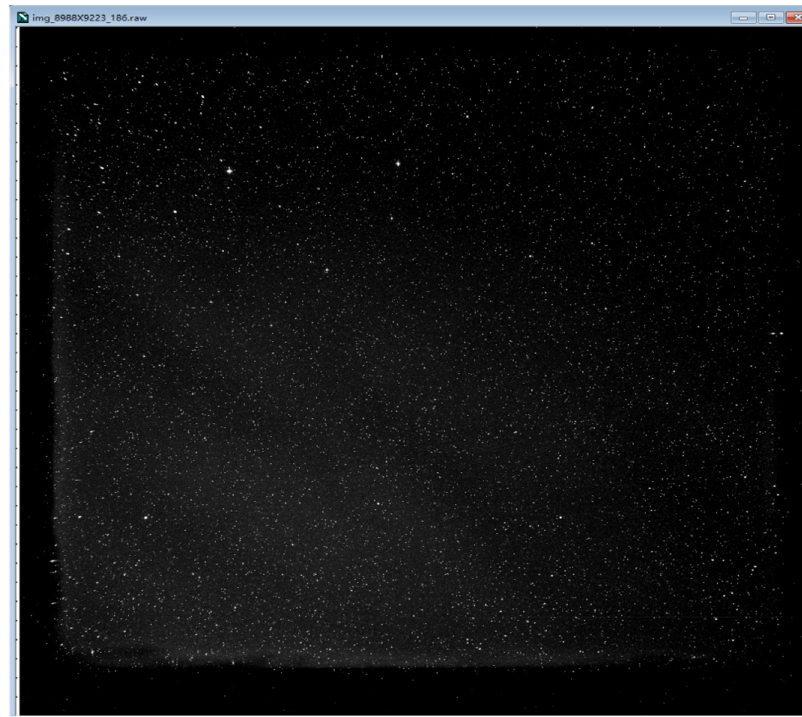
Figure 12. The star map image used this CMOS camera take.